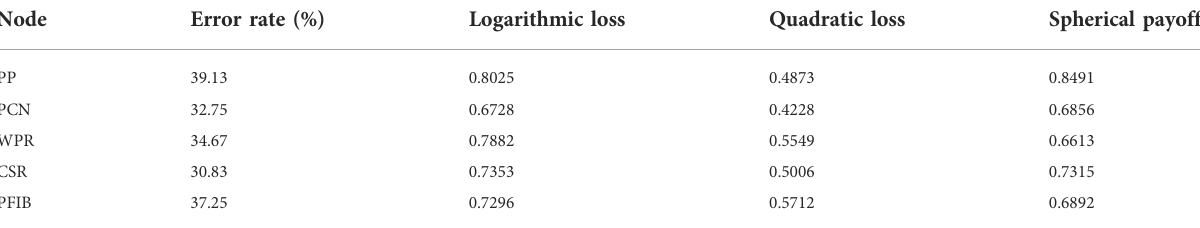
TABLE 5 Results of BBN accuracy